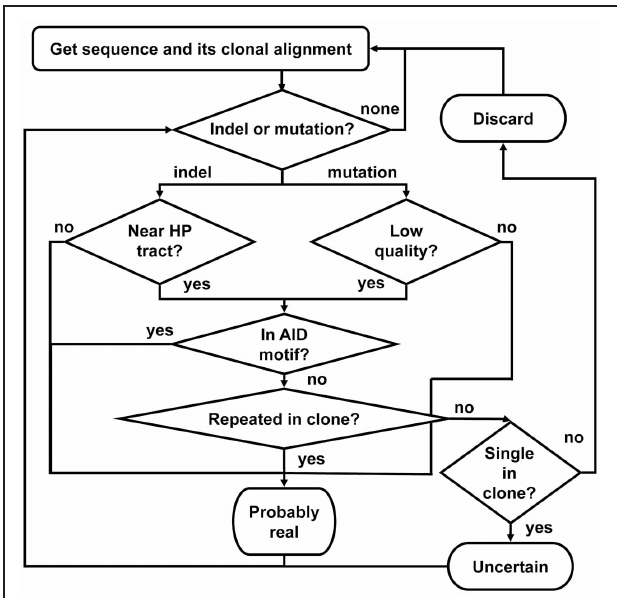
FIGURE 6 | A schematic outline of the Ig-Indel-Identifier program. “Indel or mutation?” means: “Are there (more) indels or mutations in the sequence?” “Low quality?” means: “Did the point mutation have a quality score lower than the input threshold?” “Near HP tract?” means: “Is the indel near a HPT?” “In AID motif?” means: “Is the indel or point mutation detected inside the known AID motif (AACA or the complementary TGTT)?” “Repeated in clone?” means: “Are there more sequences in the clone with the same indel?” “Single in clone?” means: “Is this the only sequence in the clone?” “Discard” means: “Discard the sequence because it has an artifact indel.” “Uncertain” means: save the sequence separately as it is suspected to have artifact indel(s), but there are no other sequences in this clone, hence we cannot be sure. “Probably real” means: save the sequence as it has a legitimate indel according to our